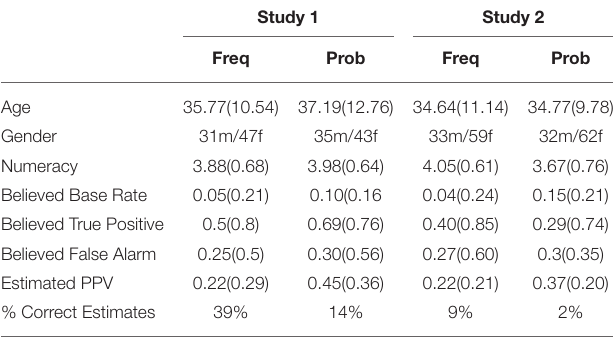
TABLE 1 | Biographical data and descriptive